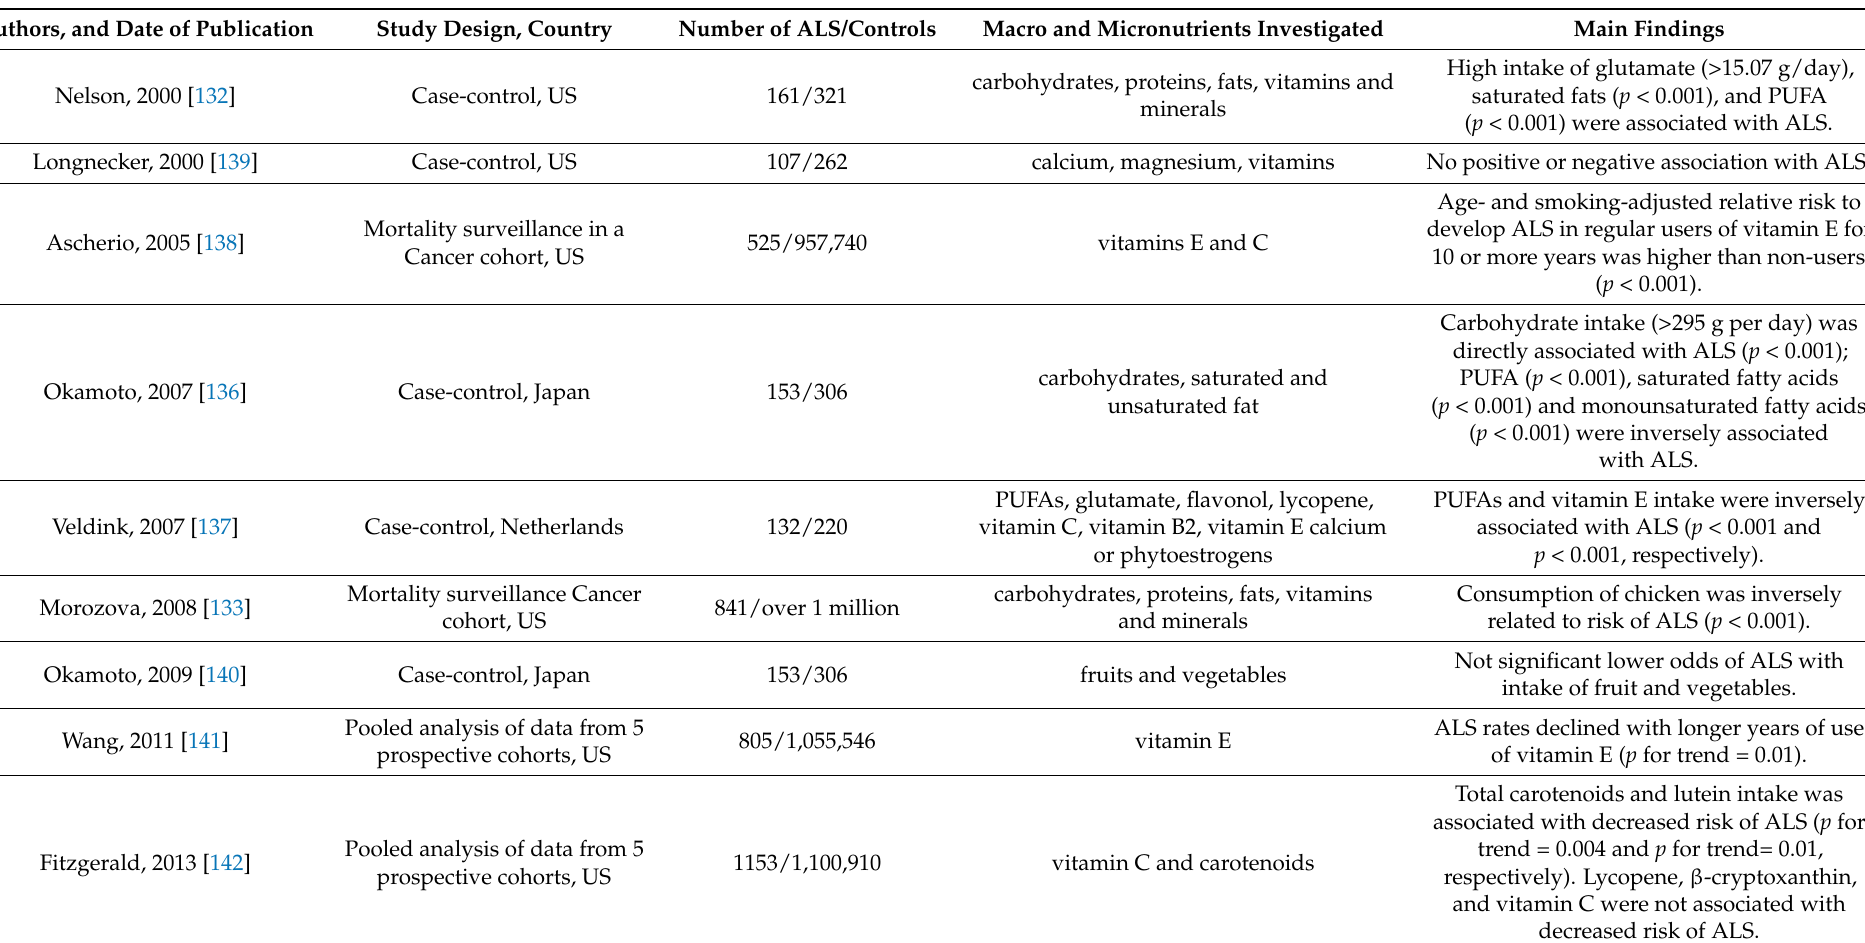
Table 2. Summary of studies on food intake in